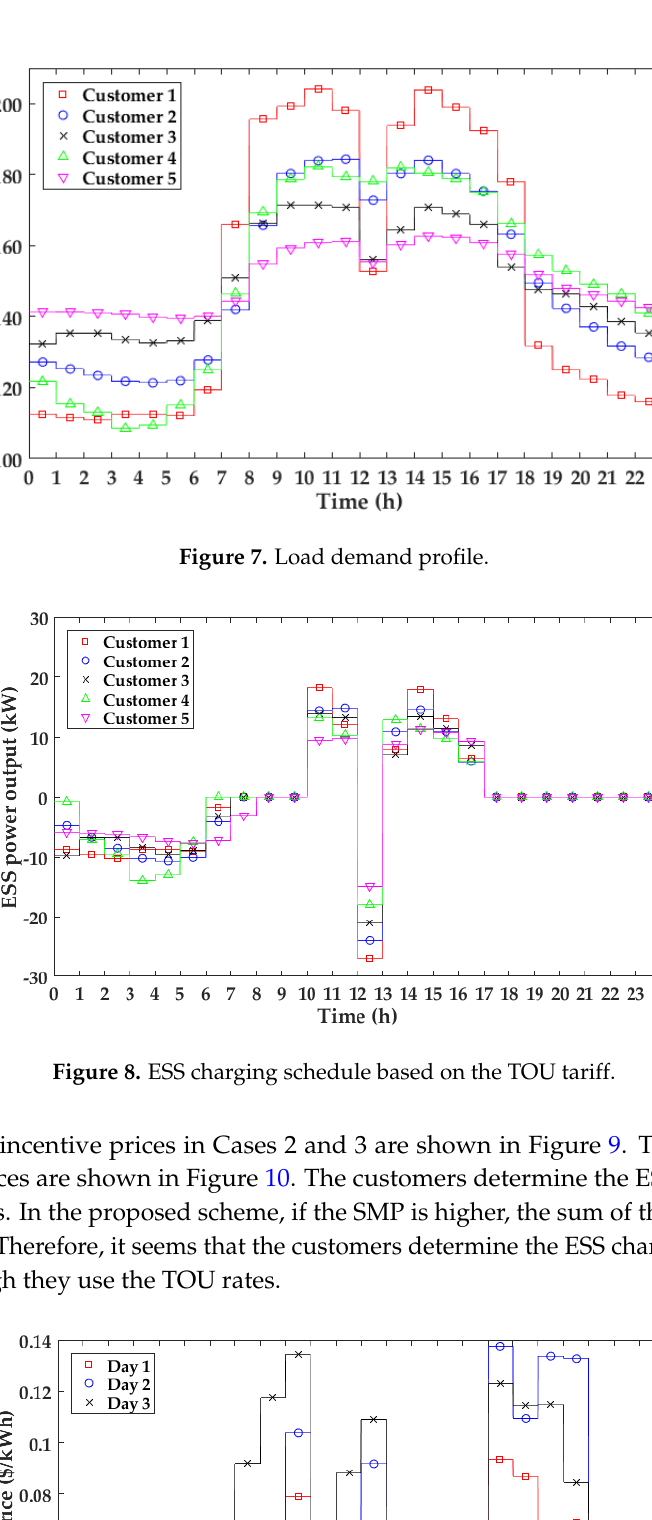
Figure 9. Incentive prices in Cases 2 and 3.